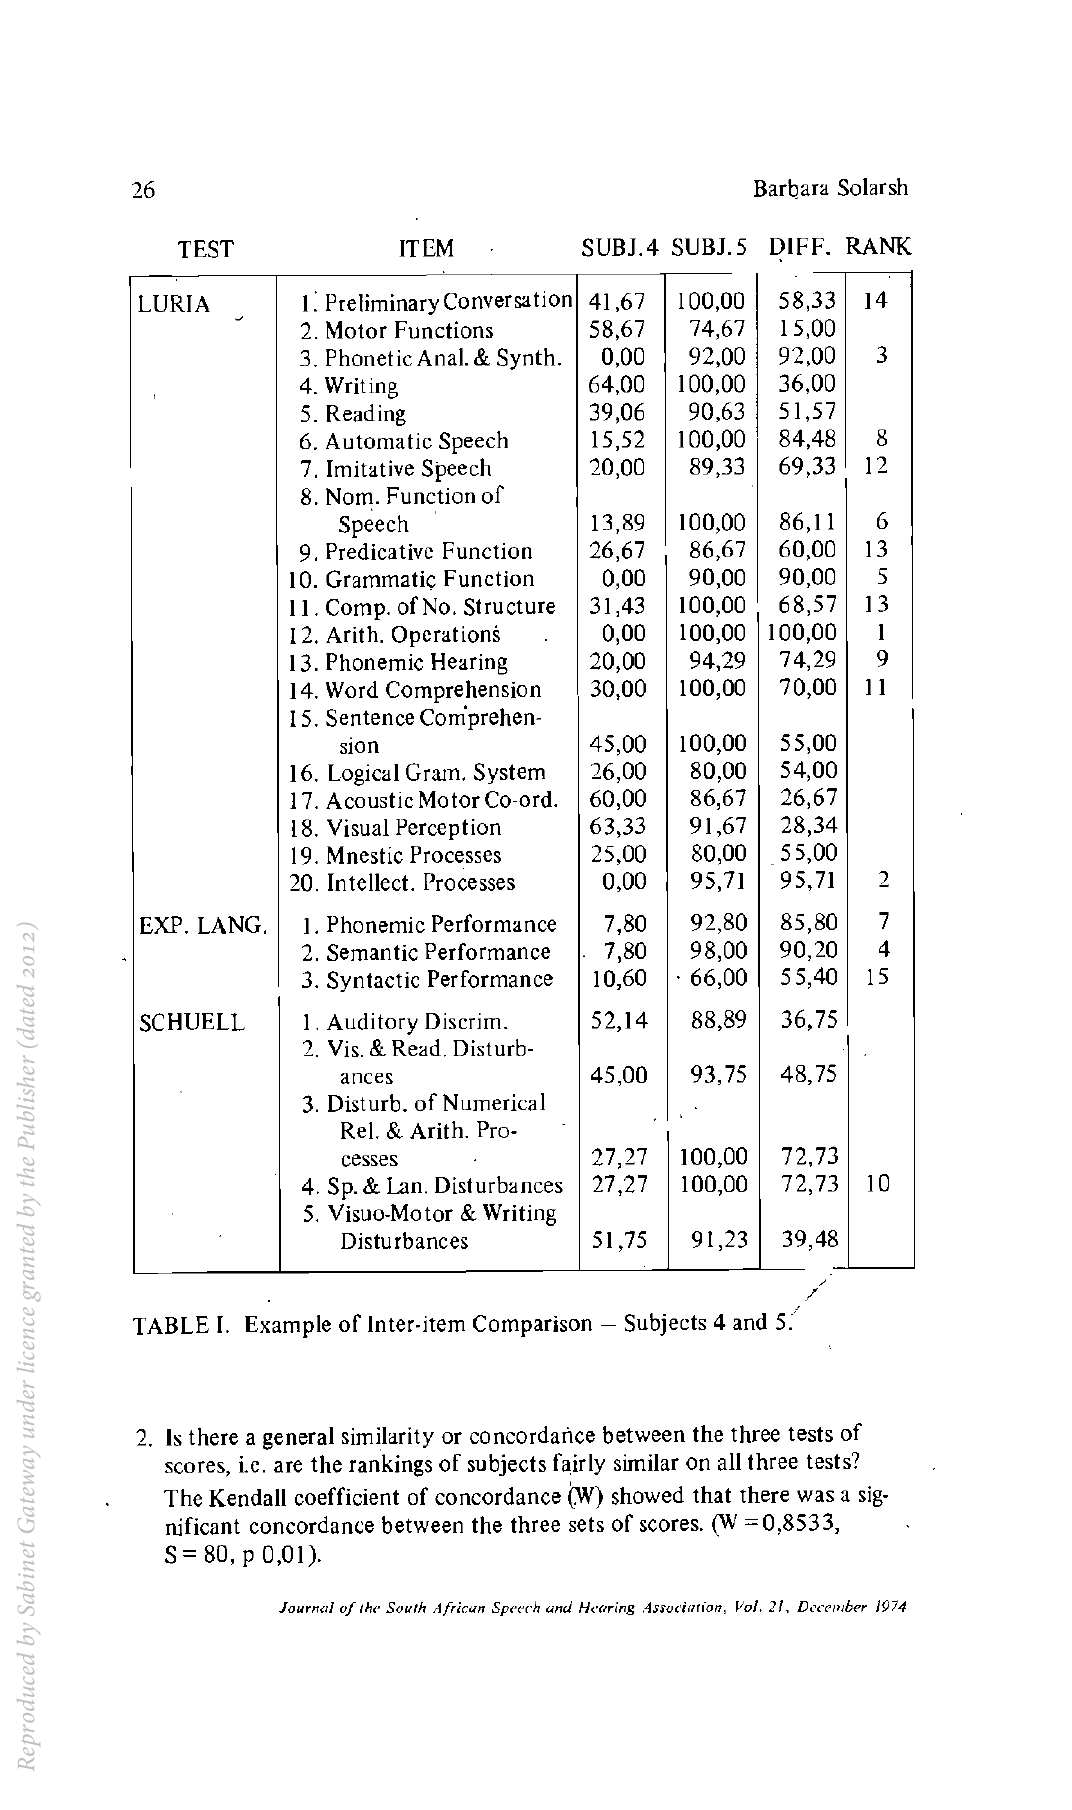
TABLE I. Example of Inter-item Comparison - Subjects 4 and 5.